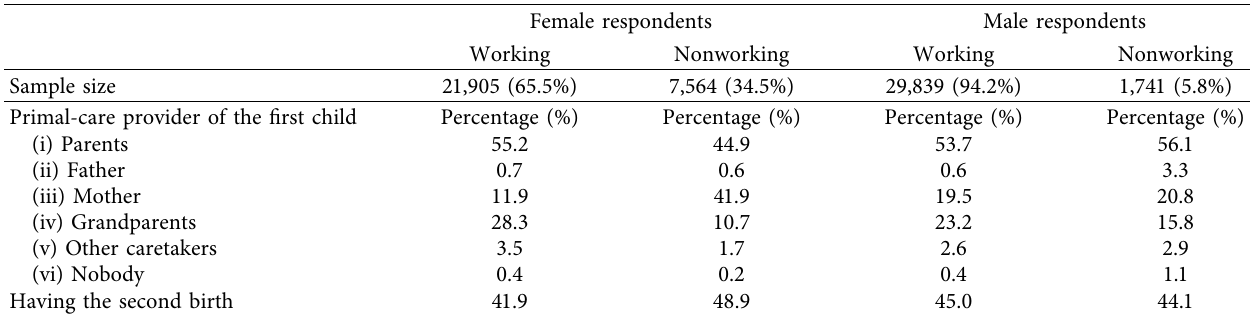
Table 6: Descriptive statistics of female respondents and male respondents given different labor-participation